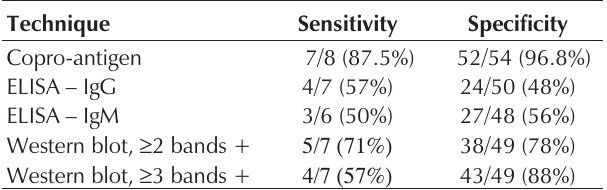
Comparison of microscopy with copro-antigen detection and serology